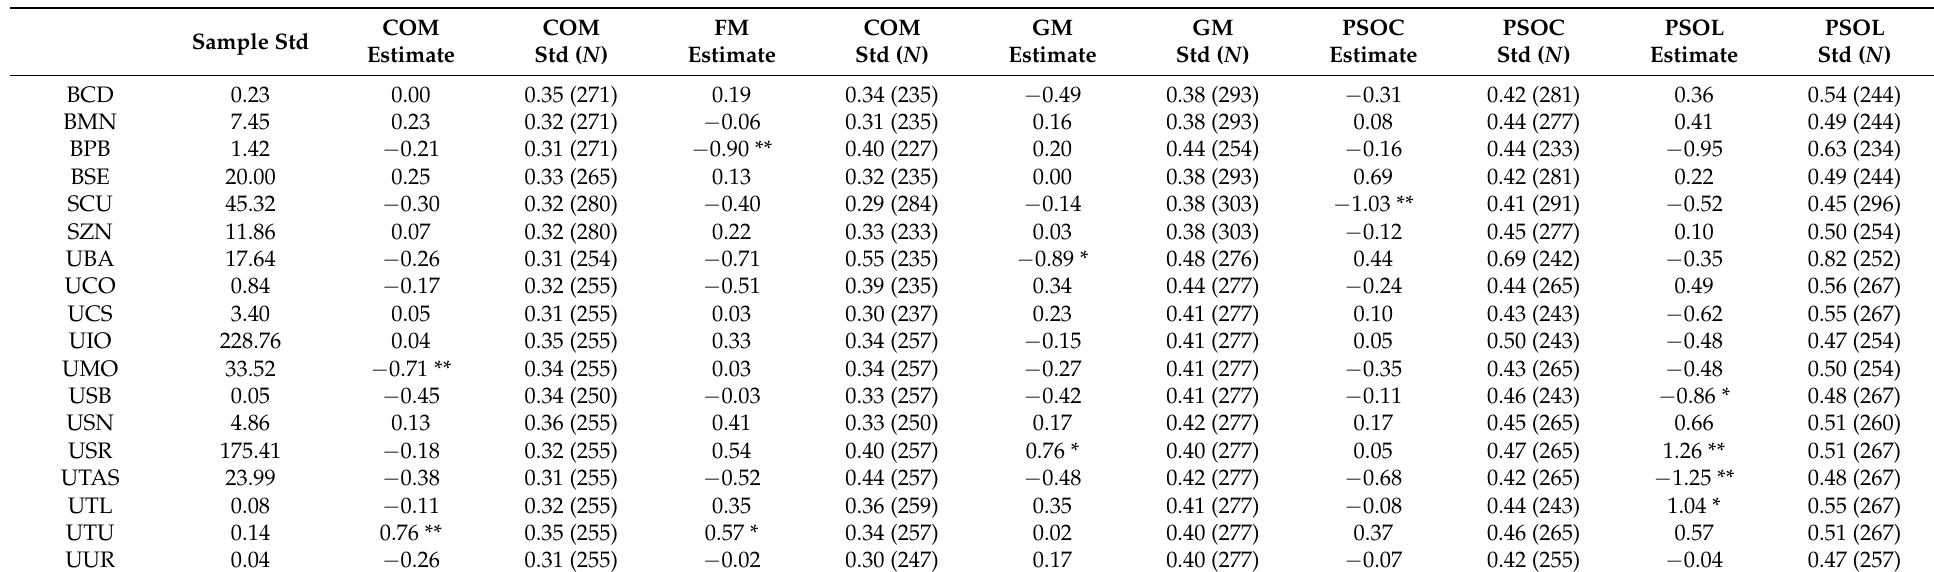
Table 6. Effects of Metals on Developmental